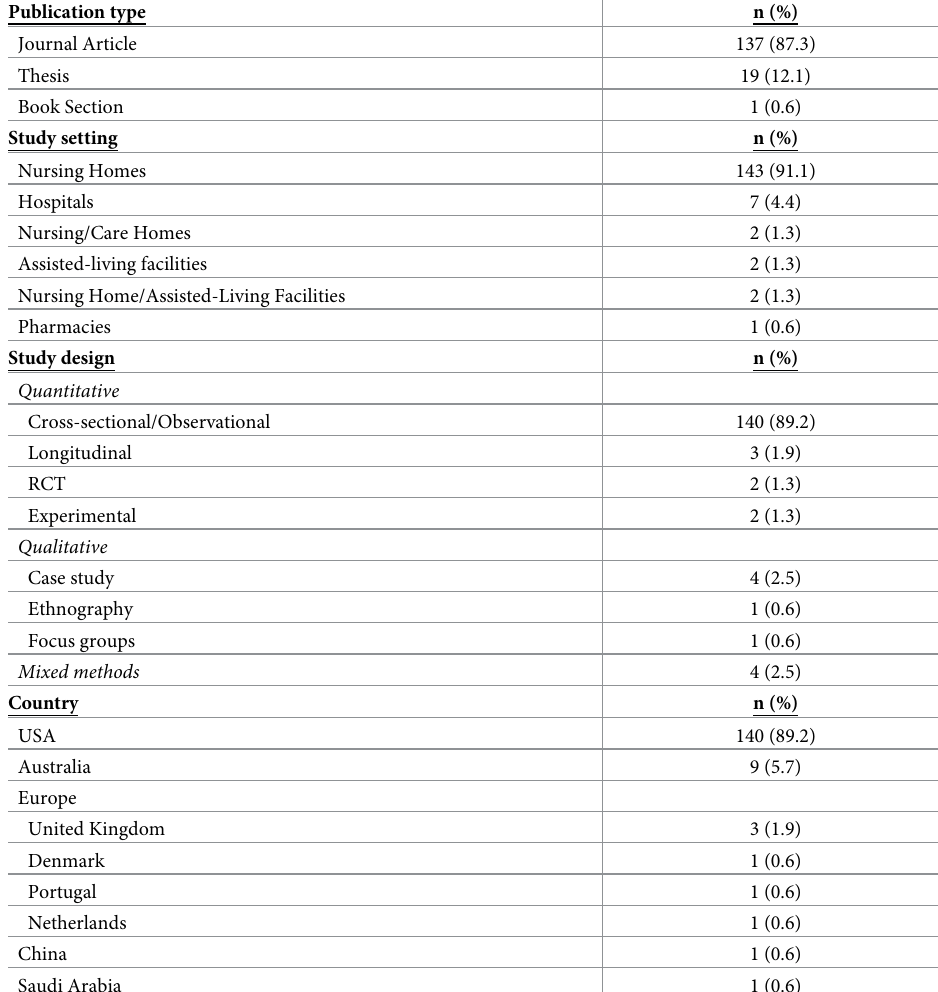
Table 1. Characteristics of studies included in the systematic